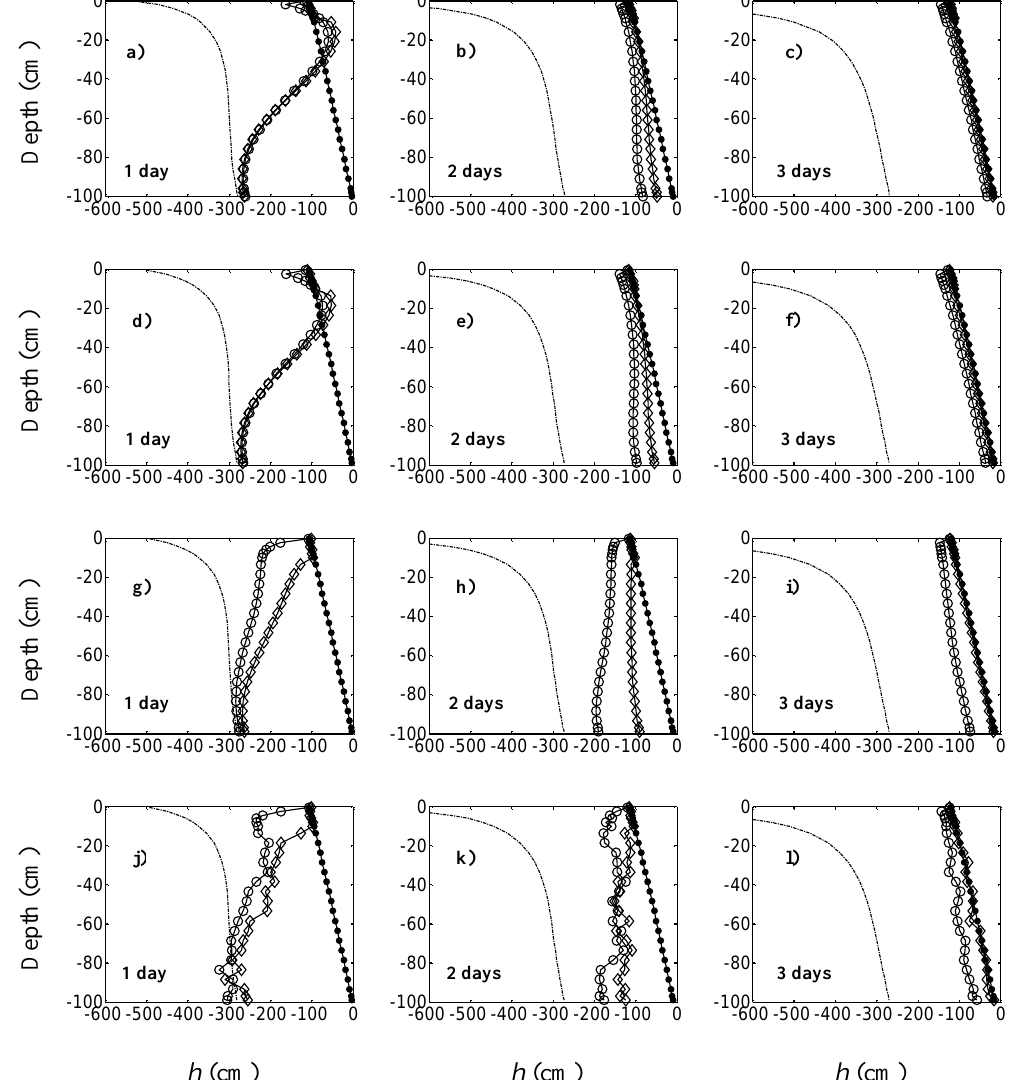
Figure 1. Retrieved profiles by assimilating daily observations of matric pressure heads involving nodes within the top 0.5cm (open circle) and 10.5cm (diamond) compared with the “true” profile (closed circle) and “guess” profile (dashed line), for different combinations of Kalman Filters and numerical schemes: (a–c) SKF-EX; (d–f) SKF-CN; (g–i) UKF-NL; (j–l) EnKF-NL.